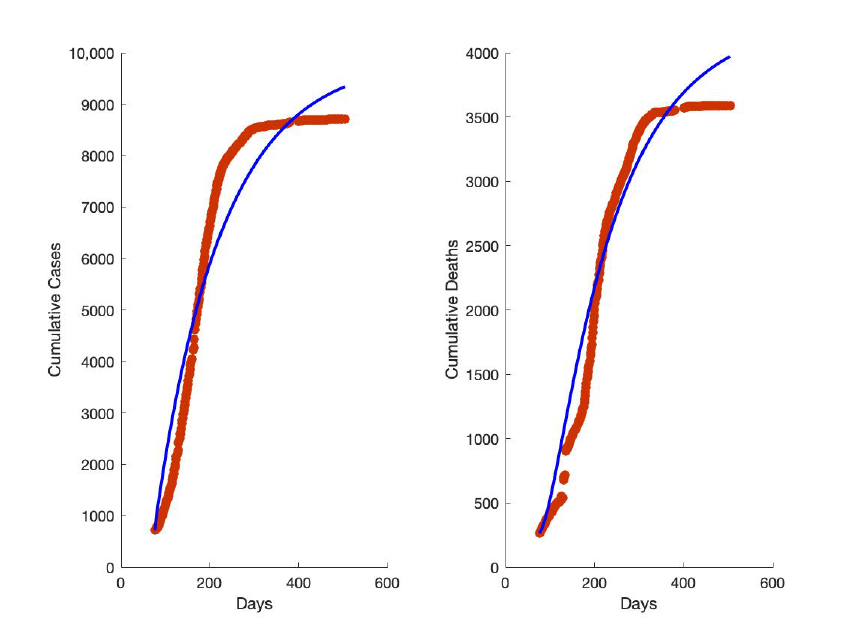
Figure A1. First attempt match to the data of cumulative cases and cumulative deaths with all parameters constant. The value of J is